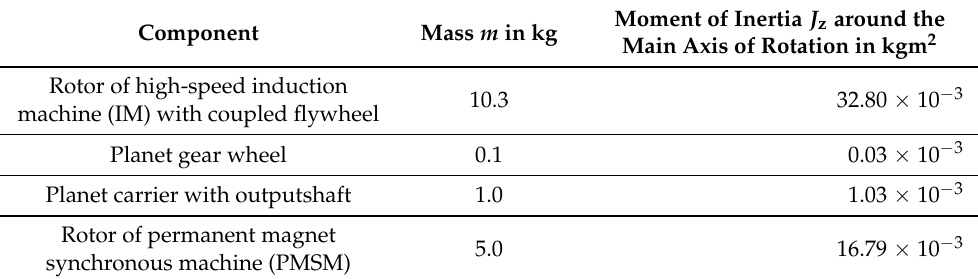
Table 1. Mechanical parameters of modelled bodies.